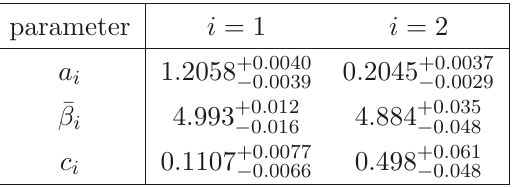
Table 2 . Results of fits to ℓ ∞ with the functional forms f i (¯ β ) of eq.